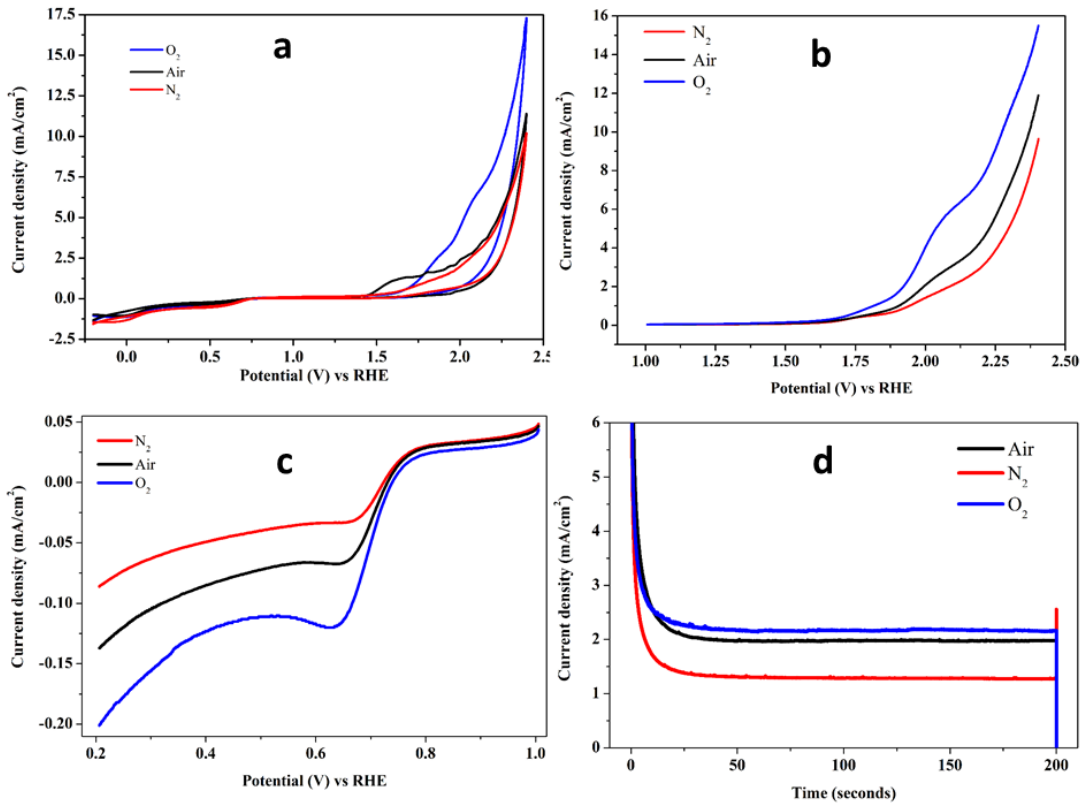
Figure 4. ( a ) CV, ( b ) LSV (OER), ( c ) LSV (ORR) curves of Ruthenium oxide photoanode in air, N 2 and O 2 saturated 0.5M KOH electrolyte vs. RHE at the scan rate of 25 mVs − 1 and ( d ) CA curves of Ruthenium oxide nanoparticles for OER activity at 1.5 V vs. RHE in O 2 -saturated 0.5M KOH.